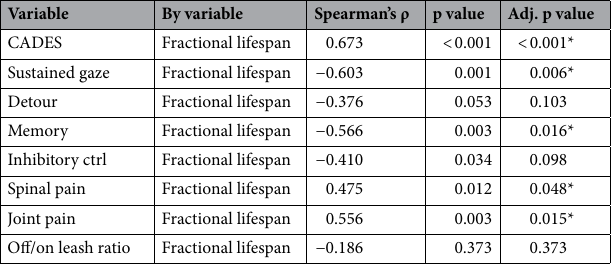
Observed statistic Global 0.05 critical value Pointwise 0.05 critical